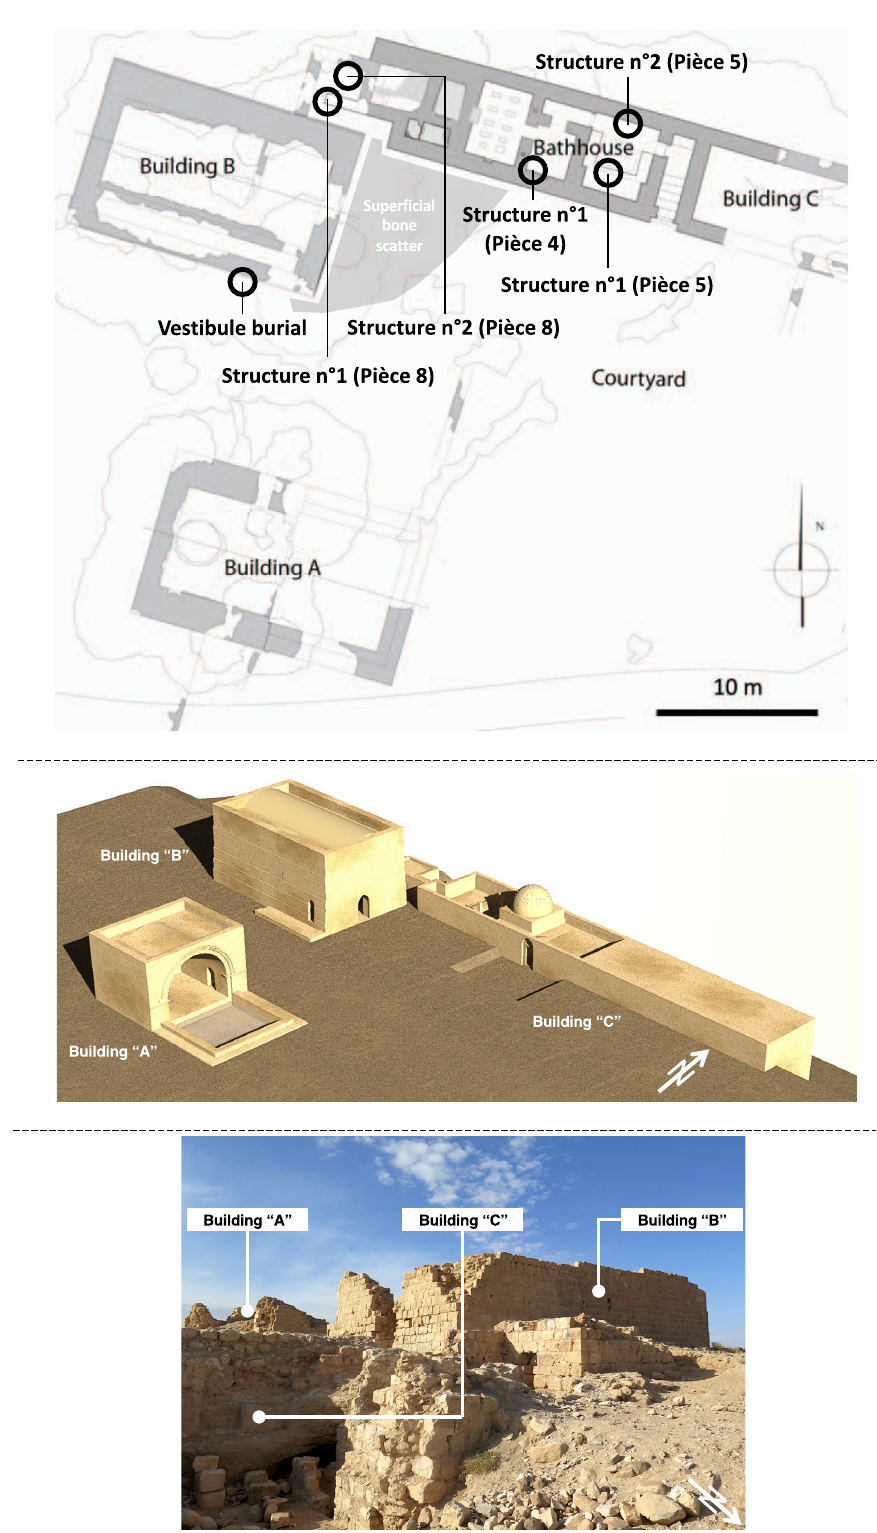
Figure 2: Map ( top ) , 3D restitution ( centre ) and photography ( bottom ) of the Khirbat al - Dusaq desert complex. Based on Vigouroux & Elter ( 2019 ) , Alby et al. ( 2019 ) , reworked by Hofstetter ( 2022 )